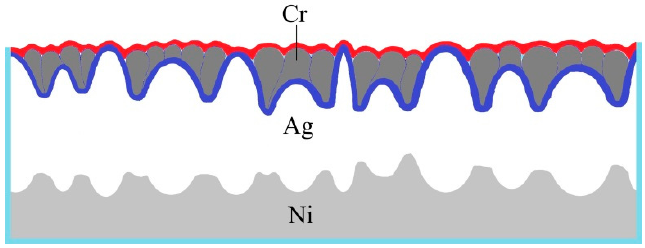
Figure 12. Schematic illustration of "inlay model".